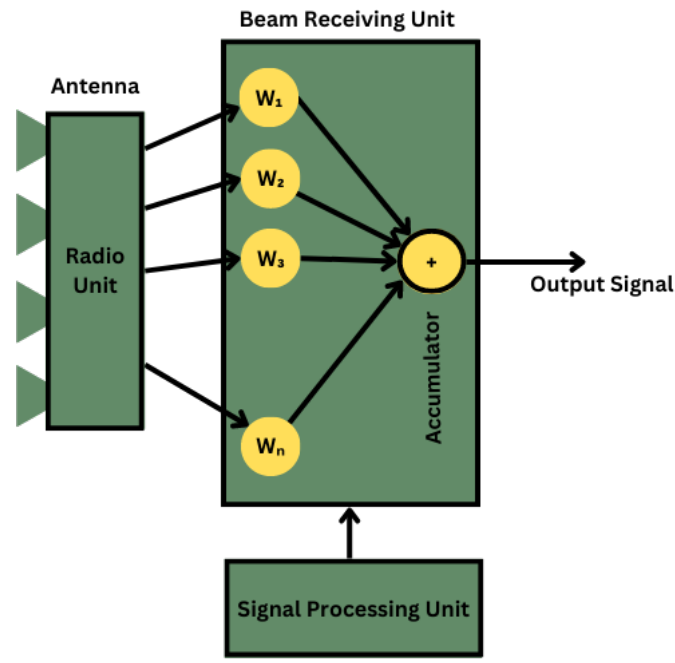
Figure 2. Receiver antenna of the proposed MIMO system.